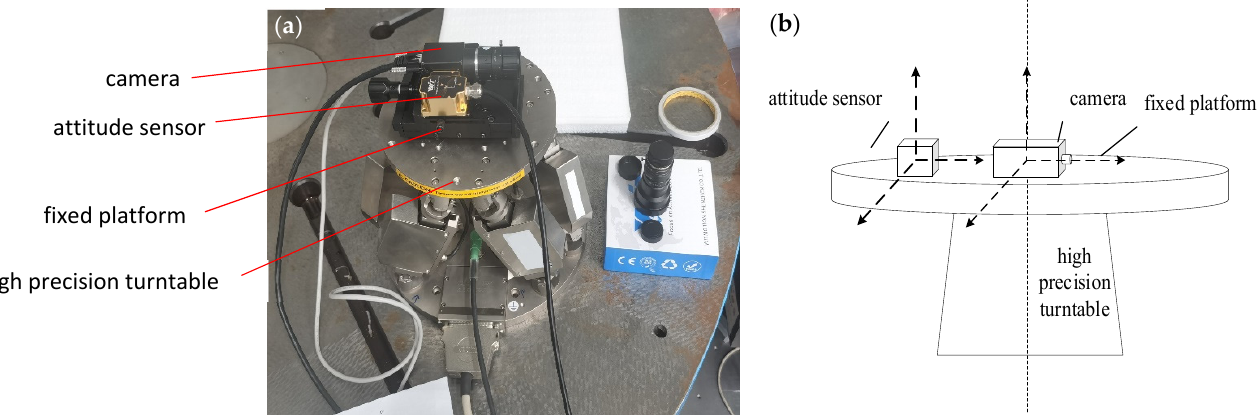
Figure 7. Experimental equipment and simulation experiment structure. ( a ) Experimental equipment; ( b ) simulated experimental structure.